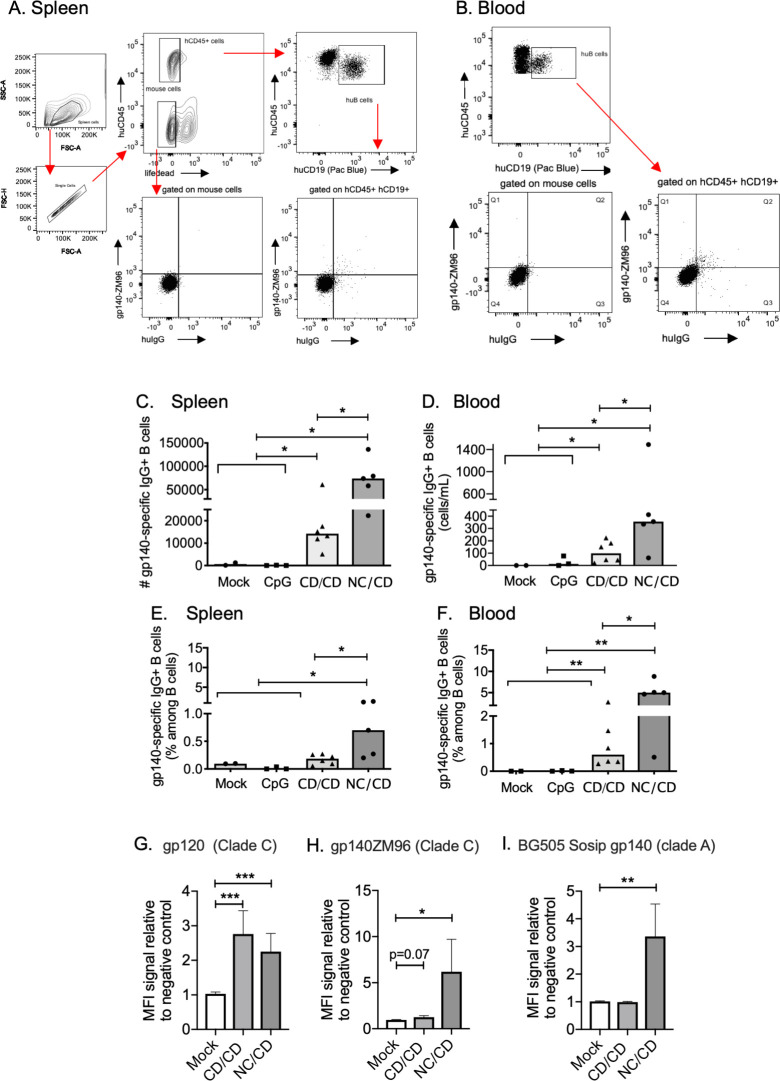
The CD/CD and NC/CD vaccination regimens elicit gp140ZM96 (Env)-specific human B cells.(A-B) Gating strategy to identify the gp140ZM96-specific IgG+ human B cells (called gp140+). (A) Flow cytometry of splenocytes from concatenated NC/CD hu-mice cells one week after the last injection (w6). After gating for single cells, viable cells within the huCD45+ gate were represented in a huCD45 versus huCD19 dot blot. Then hu-B cells were represented in a gp140ZM96 versus huIgG dot blot. The control staining for gp140ZM96 and huIgG are showed by gating on mouse cells. (B) The same gating strategy was used to identify the blood gp140+-specific IgG+ human B cells from concatenated NC/CD hu-mice cells one week after the last injection (w6). (C-D) Total number of gp140+ IgG+ human B cells in the spleens (C) and blood (D) of hu-mice. (E-F) Frequencies of gp140+ IgG+ human B cells in the spleens (E) and blood (F) of hu-mice. (C to F) Individual values are presented, along with the median. (G to I) Plasma HIV-1-specific human antibodies from hu-mouse samples evaluated for HIV-1 gp120 (G), gp140ZM96 (H) and BG505 SOSIP gp140 (I) binding by a custom multiplex assay (mean +/- sem). Three independent determinations were performed in triplicate. Mann-Whitney U-tests were used for comparisons. *p < 0.05, **p<0.01, ***p<0.001.